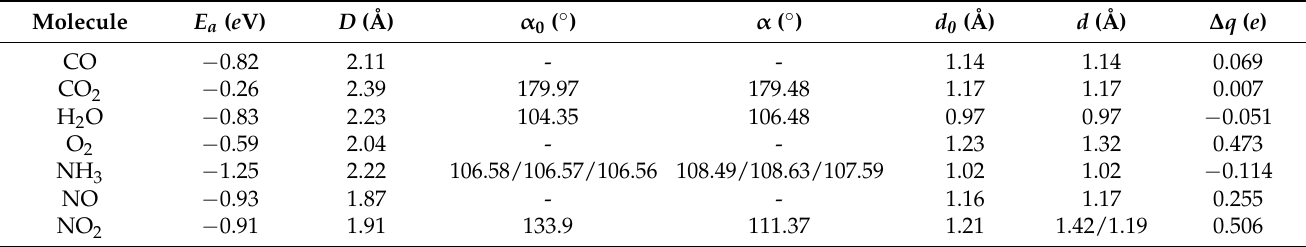
Table 1. Characteristics of the most energetically favorable adsorption sites in the V 3 S 4 nanosheet with different molecules adsorbed to the surface. E a is the energy of adsorption; D is the perpendicular distance between molecule and adsorption site (V atom); α 0 and α are the bond angles in V-shaped molecules before and after adsorption; d 0 and d are the molecules bond lengths before and after adsorption; and ∆ q is the change in charge of the molecule between states before and after adsorption (within the Bader theory calculation